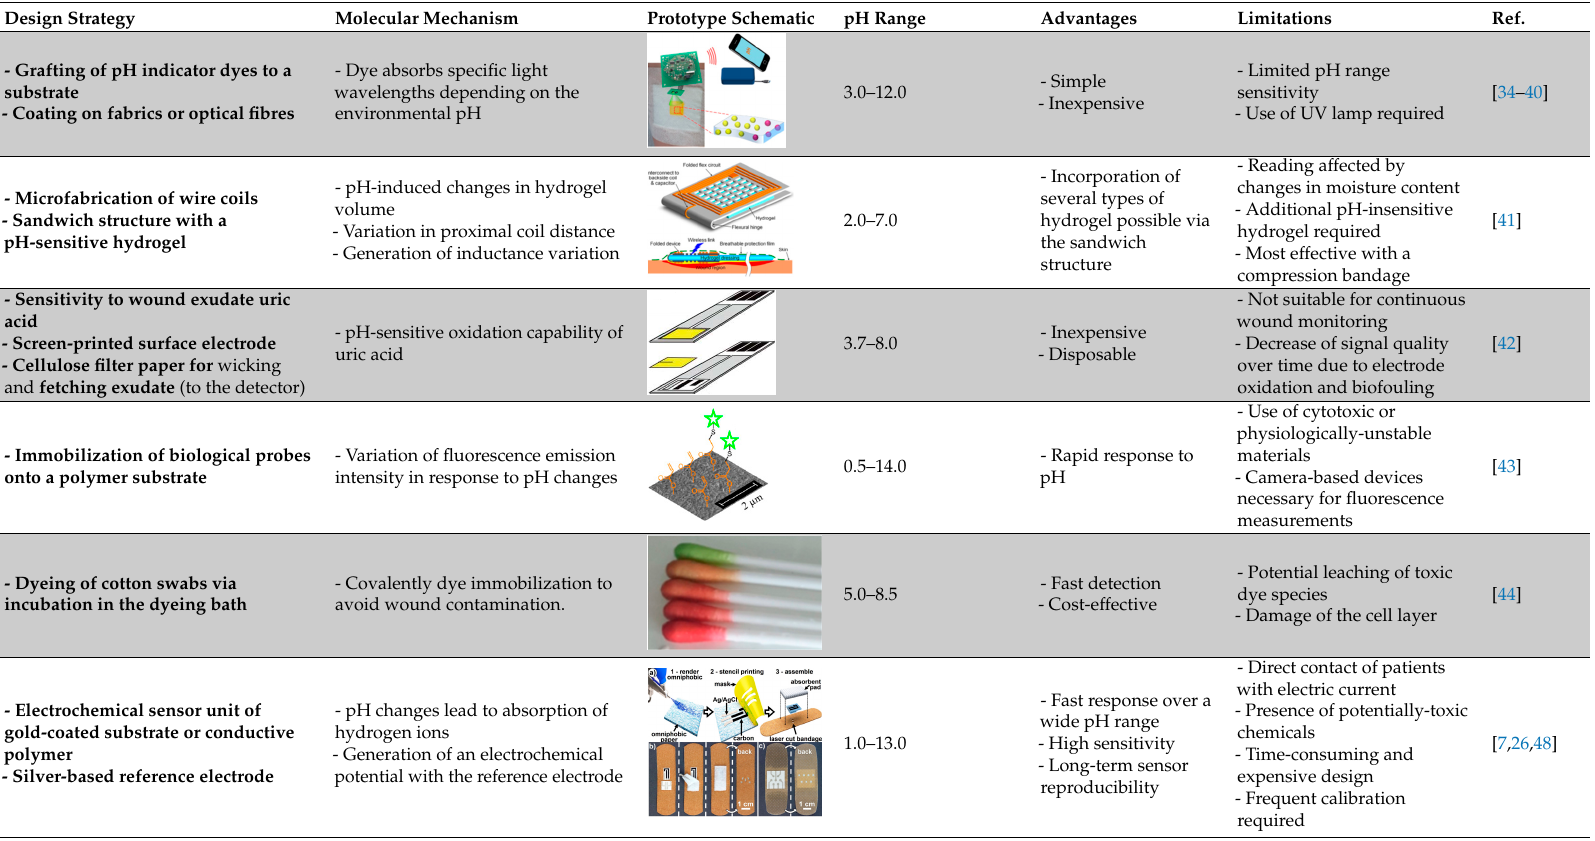
Table 1. State ‐ of ‐ the art design of wound pH sensors.